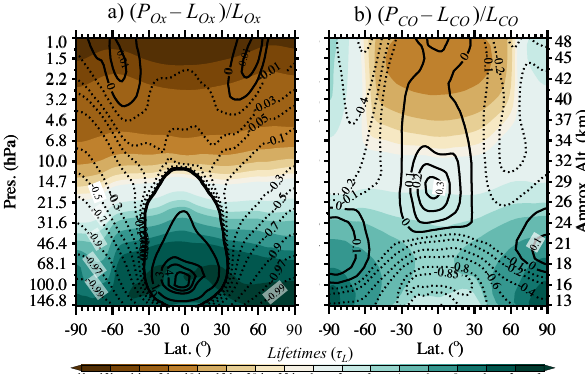
Fig. 2 with chemical lifetime superimposed, using the same color scale